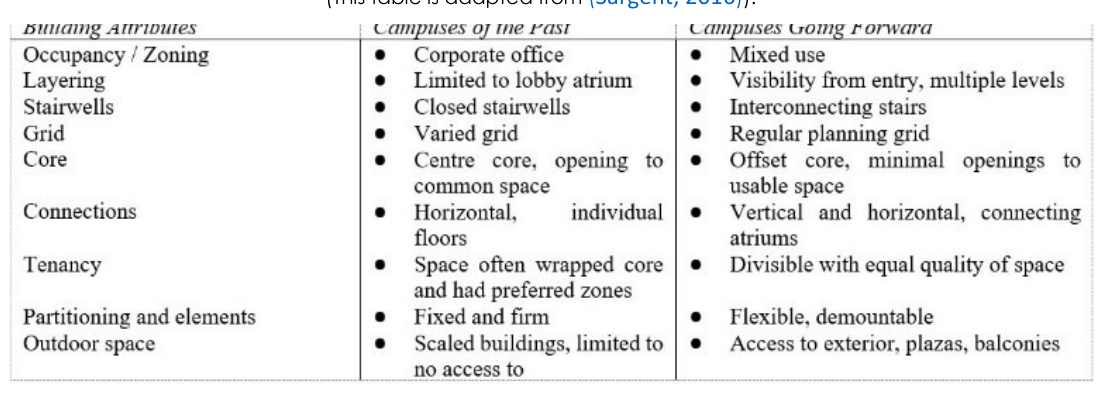
Table 2. Comparison of Spatial Attributes between Past and Contemporary Campus Typologies (This table is adapted from ( Sargent, 2016